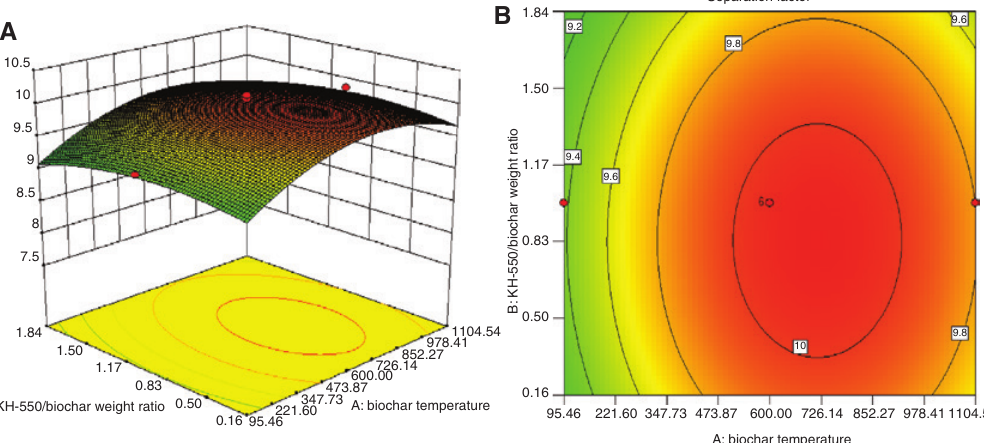
Figure 3: 3D surface plot (A) and contour plot (B) exhibiting the influences of the BB temperature and the crosslinker/BB weight ratio on the separation factor.